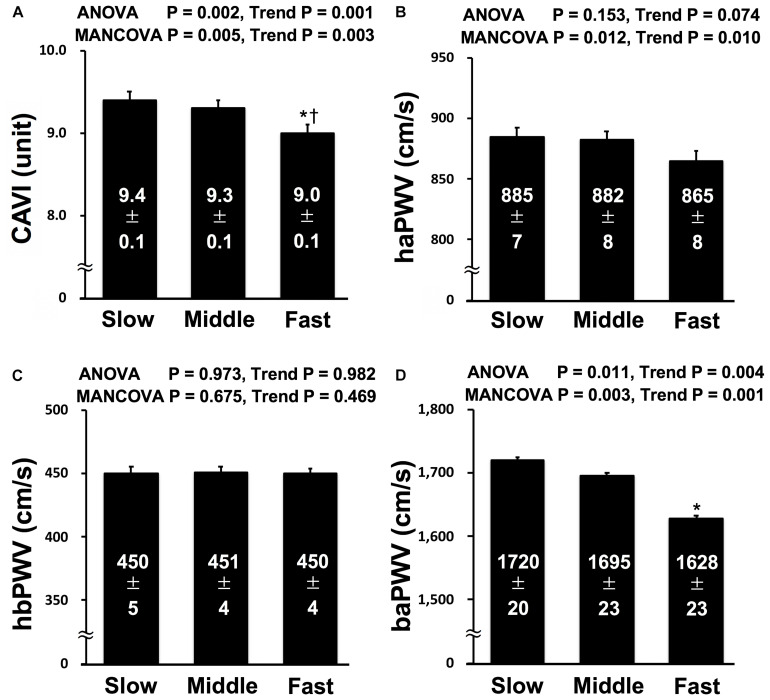
Comparisons of CAVI (A), haPWV (B), hbPWV (C), and baPWV (D) in each tertile. CAVI, cardio-ankle vascular index; haPWV, heart-ankle pulse wave velocity; hbPWV, heart-brachial pulse wave velocity; baPWV, brachial-ankle pulse wave velocity; Slow, lowest tertile (≤ 1.54 m/s in men and ≤ 1.49 m/s in women); Middle, middle tertile (1.55 m/s to 1.83 m/s in men and 1.50 m/s to 1.78 m/s in women); Fast, highest tertile (≥ 1.84 m/s in men and ≥ 1.79 m/s in women). MANCOVA; the model was adjusted multicollinearity of arterial stiffness indices and confounding factors such as age, gender, body mass index, mean blood pressure, heart rate, cognitive function, handgrip strength, flexibility, smoking status, exercise status, anti-hypertensive medication, and anti-hyperlipidemic medication. *P < 0.05 vs. Slow; †P < 0.05 vs. Middle.